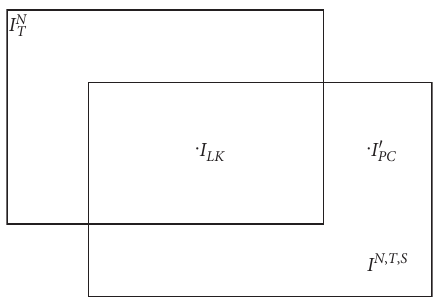
Figure 7: Sets of ( T,N ) - and D ′ -implications.